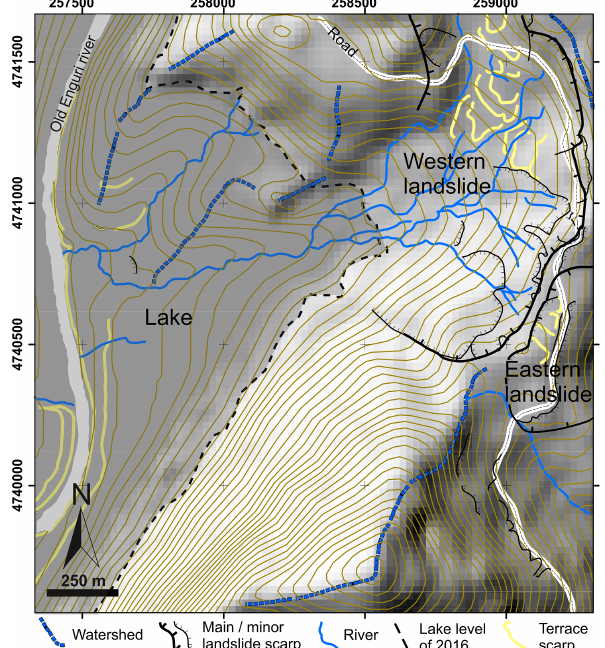
Figure 5. Geomorphological map of the area surrounding the west- ern landslide, based on our new field surveys in the onshore zone and data from Zolotarev et al. (1968) for the zone now submerged by the Enguri water reservoir. The main head scarp of the other landslide facing east is also